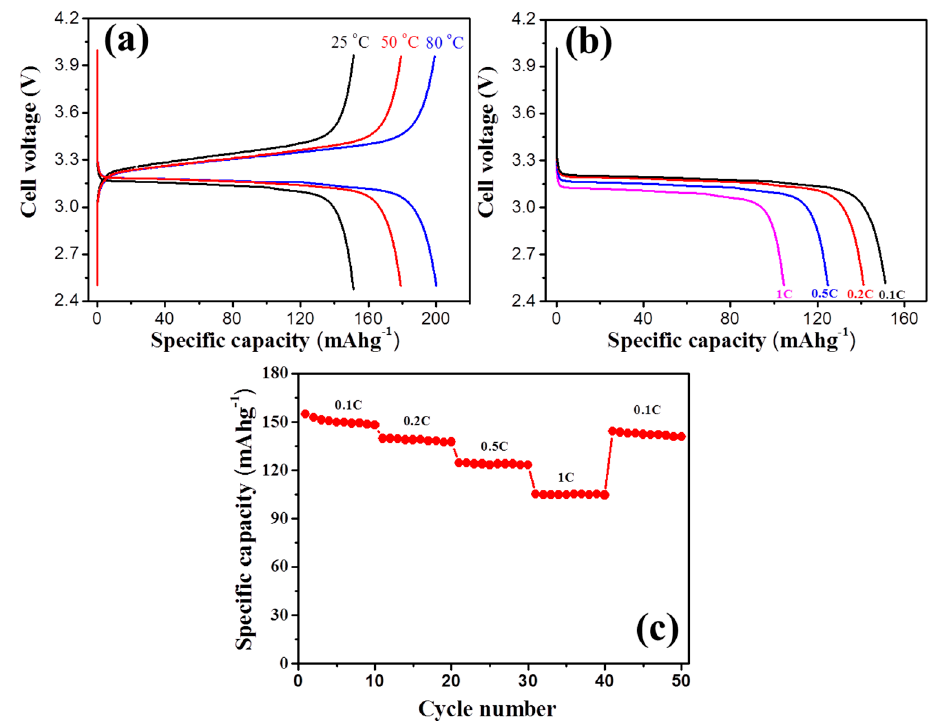
Figure 8. ( a ) Charge and discharge profiles under 25 °C, 50 °C, and 80 °C at a current rate of 0.1 C; ( b ) discharge profiles at various C-rates from 0.1 to 1 C (25 °C); ( c ) rate performances of the cell at 25 °C, where discharge current densities are varied from 0.1 to 1.0 C at a constant charge current density of 0.1 C.